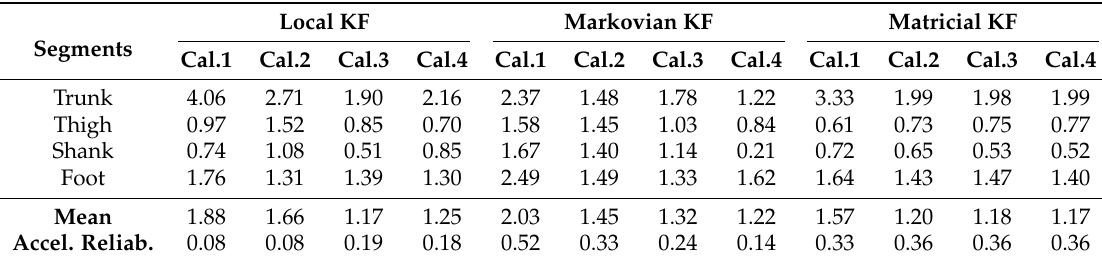
Table 1. Performance index of all combinations of filters and calibrations assessed using the RMSE (deg). The percentage of time the accelerometers are used in the KF updates is shown on the bottom row (% total trial duration). Local KF Markovian KF Matricial Segments